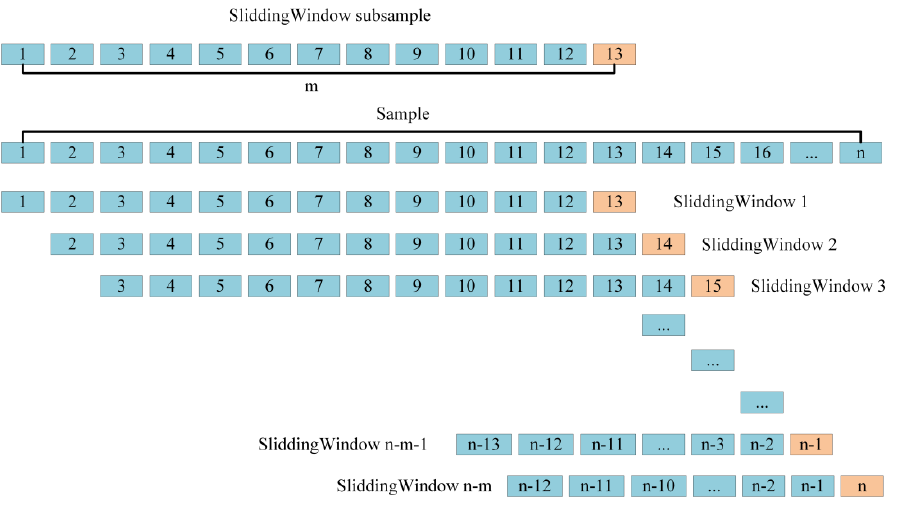
Figure 3. Sample making process in this